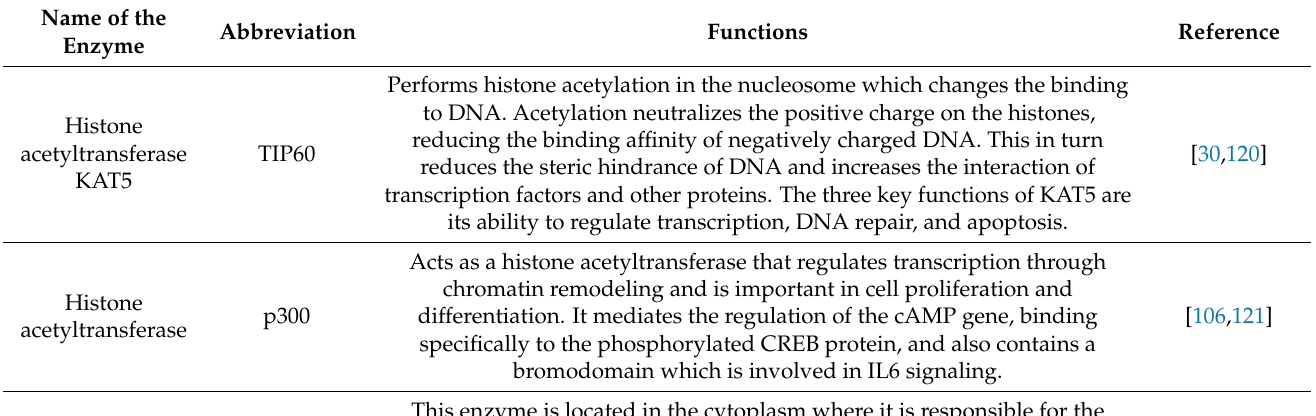
Table 4. Effect of enzymes on the acetylation process of the Foxp3 transcription